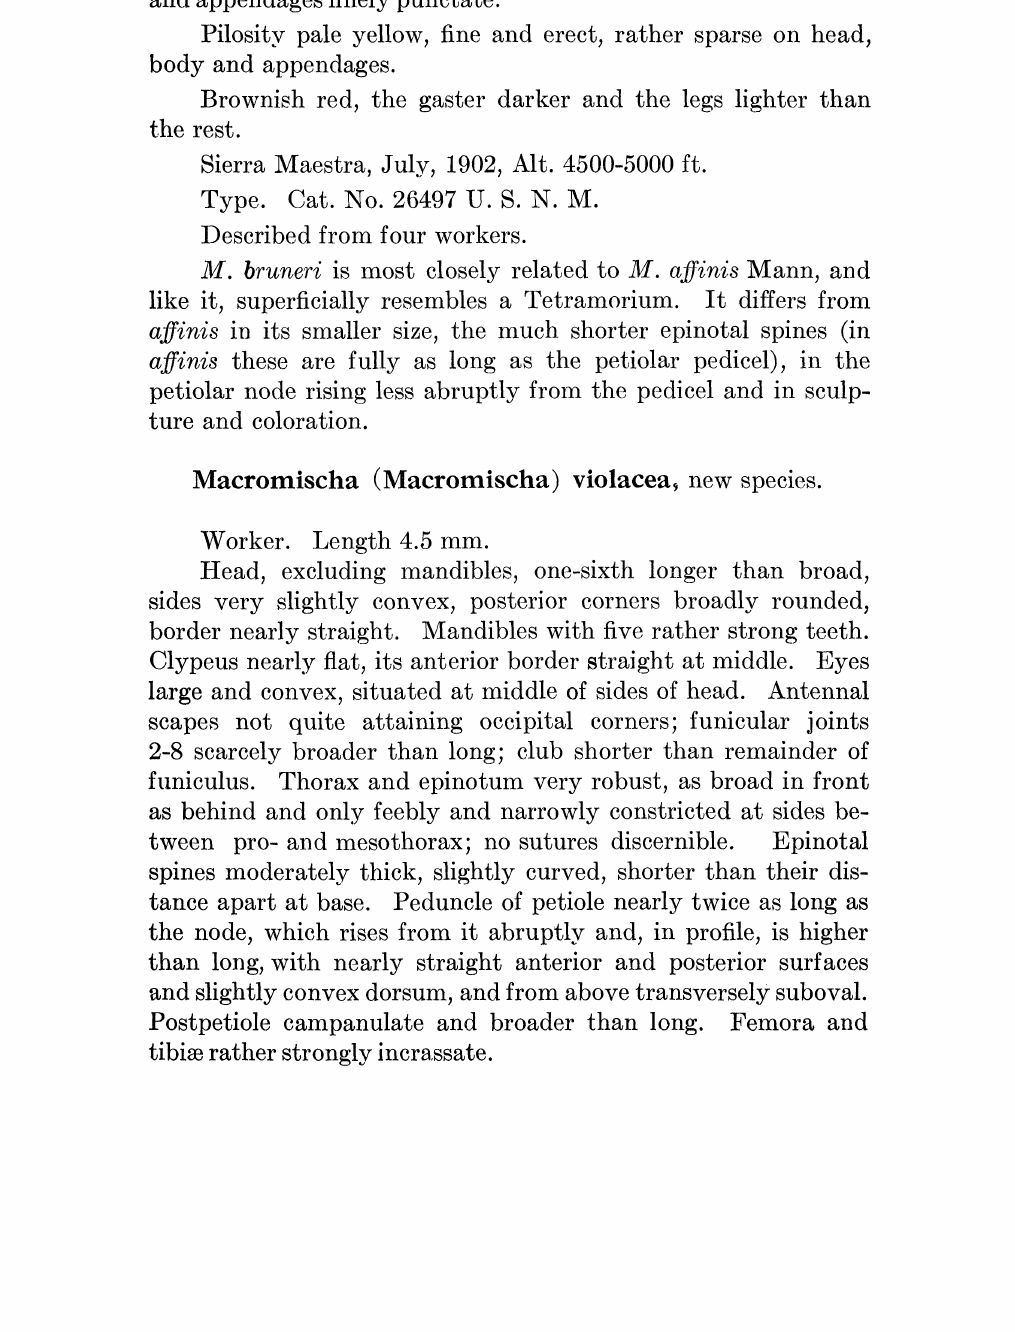
pronotum; petiolar pedicel subtly punctate, nodes of petiole and postpetiole smooth above, obliquely striate at sides. Gaster and appendages finely